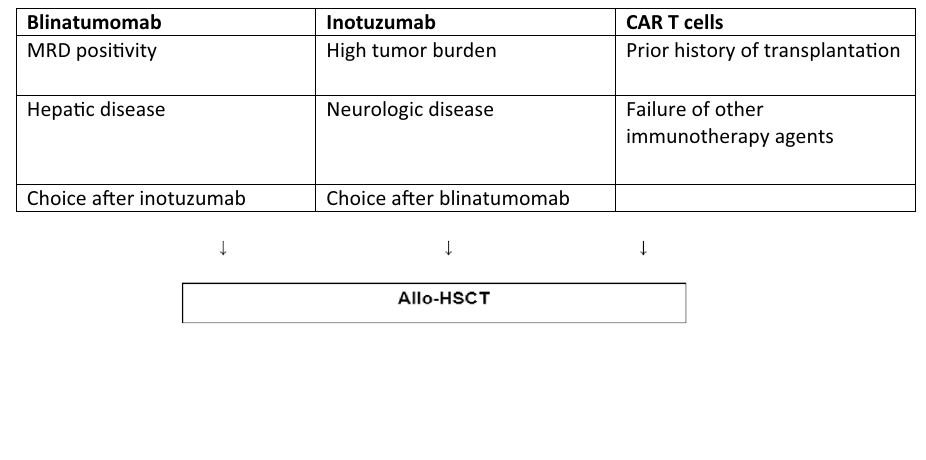
immunotherapy [4, 5, 15, 44, 49, 53, 54]